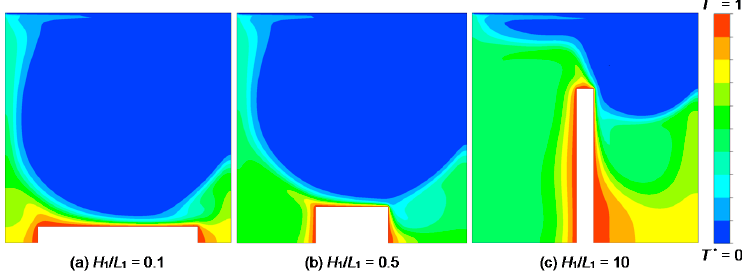
Figure 9. Dimensionless thermal contours for various fin aspect ratios ( H 1 / L 1 ) at Re =1000 and Ra = 10 5 for the fin area fraction of 0.05 and an Al 2 O 3 -volume fraction of 1%. ( a ) H 1 / L 1 = 0.1; ( b ) H 1 / L 1 = 0.5; ( c ) H 1 / L 1 = 10.